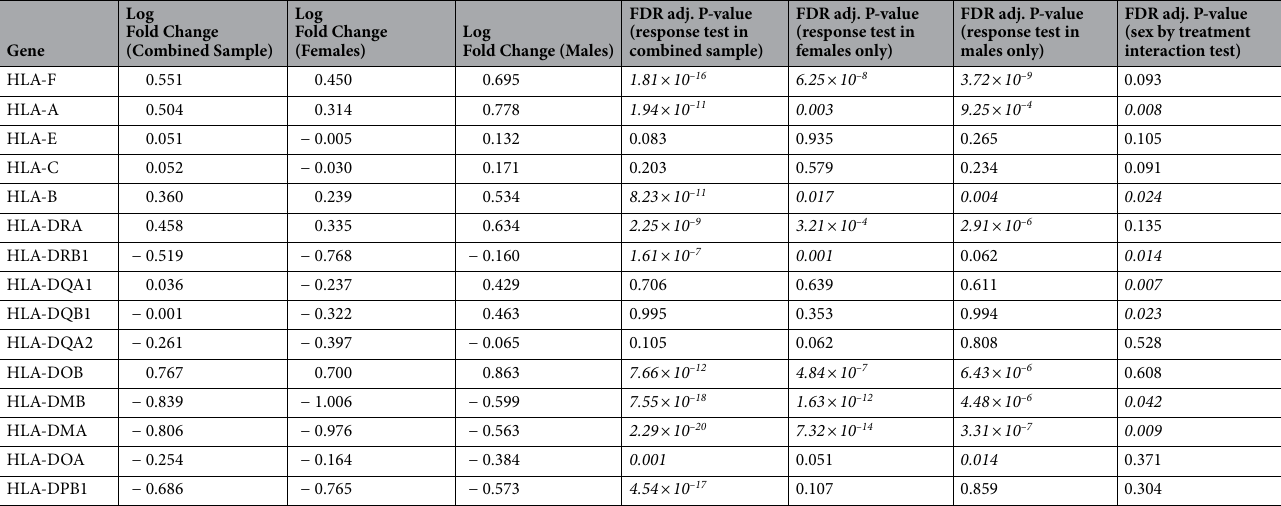
Table 2. The log fold change responses of HLA genes expressed in PBLs to LPS treatment in the combined (n = 112), female (n = 66), and male (n = 46) samples. Also presented are FDR-adjusted p-values for four tests: (1) test of significant response in the combined sample, (2) test of significant response in females, (3) test of significant response in males, and (4) test for sex by treatment interactions in the combined sample. Genes are presented in order from the telomeric to the centromeric end of the short arm of chromosome 6. Significant FDR-adjusted p-values < 0.05 are denoted with italics